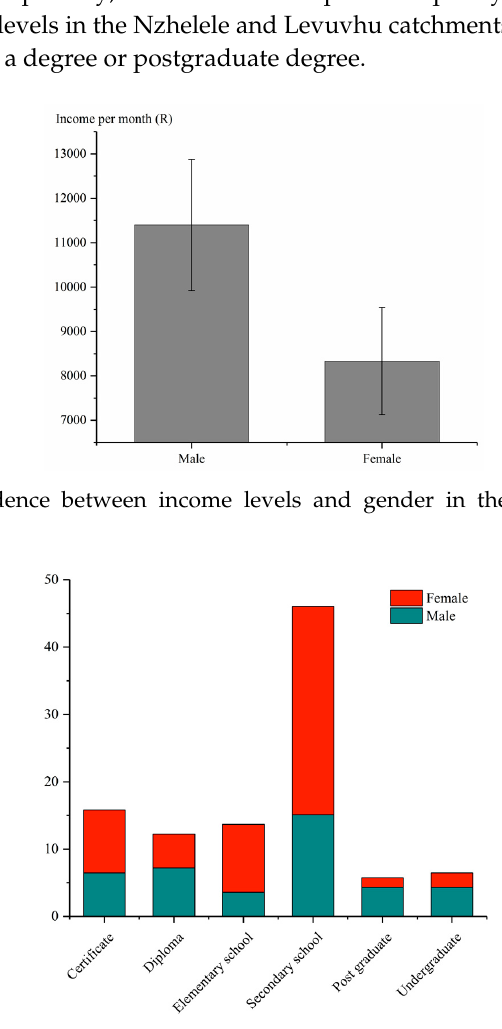
Figure 4. Employment levels according to gender levels in the Nzhelele and Levuvhu river catchments.